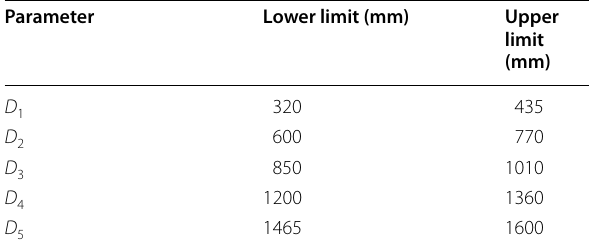
Table 4 Range of available moving positions